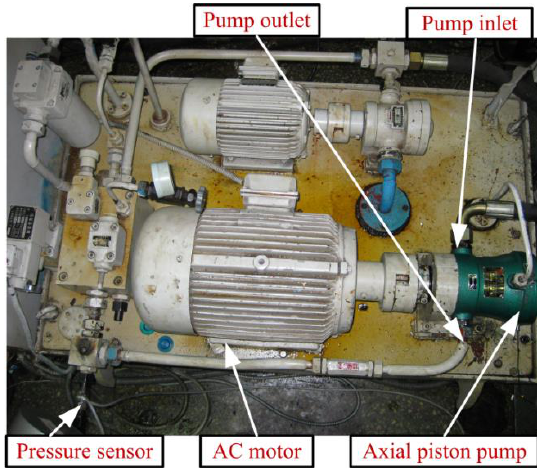
Figure 5. The experimental platform for the pump’s degradation status recognition.